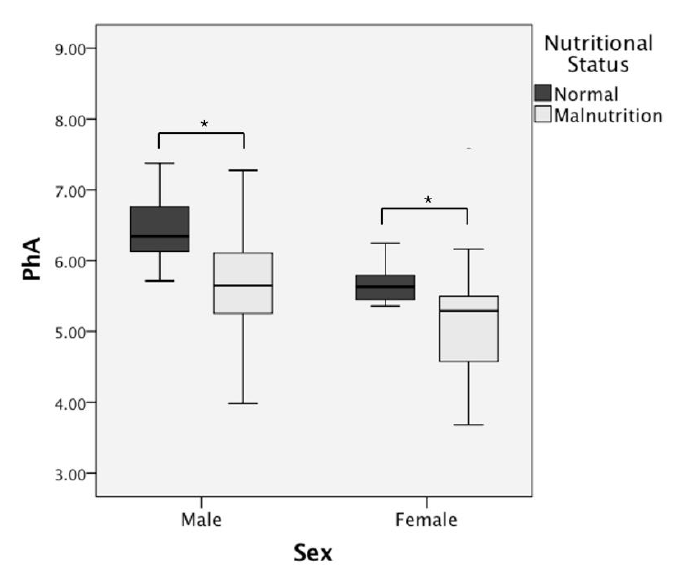
Figure 1. Box plot comparing PhA in CD patients with different nutritional statuses. Note: *: p < 0.05.